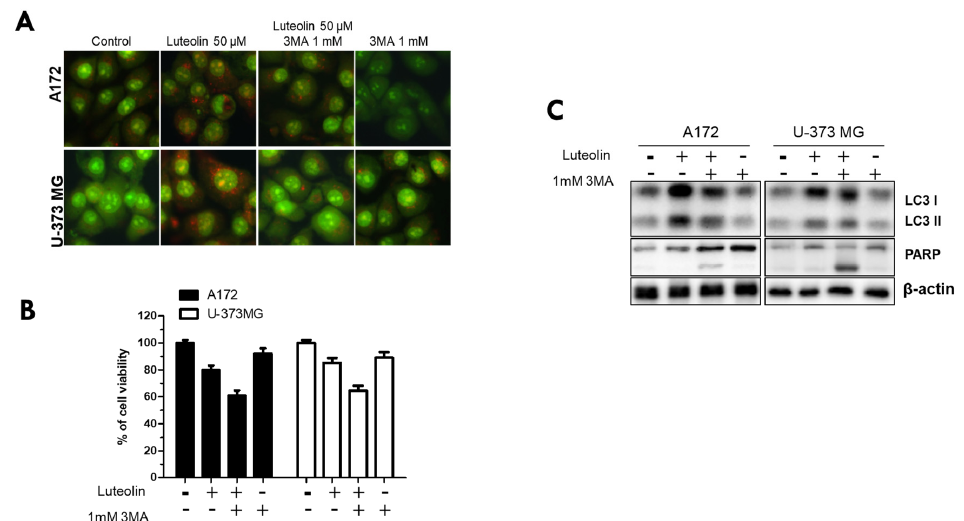
Figure 6. Inhibition of luteolin-induced autophagy further promotes cell death. A172 and U-373MG cells were pretreated for 1 h with 3MA (1 mM), an inhibitor of autophagy, followed by treatment with luteolin (50 μ M) and then cultured for 24 h. The inhibitory effect of autophagy was confirmed by AO staining ( A ), MTT assay ( B ), and Western blot assay ( C ). β -actin was used as loading control. The results are expressed as mean ± SD.